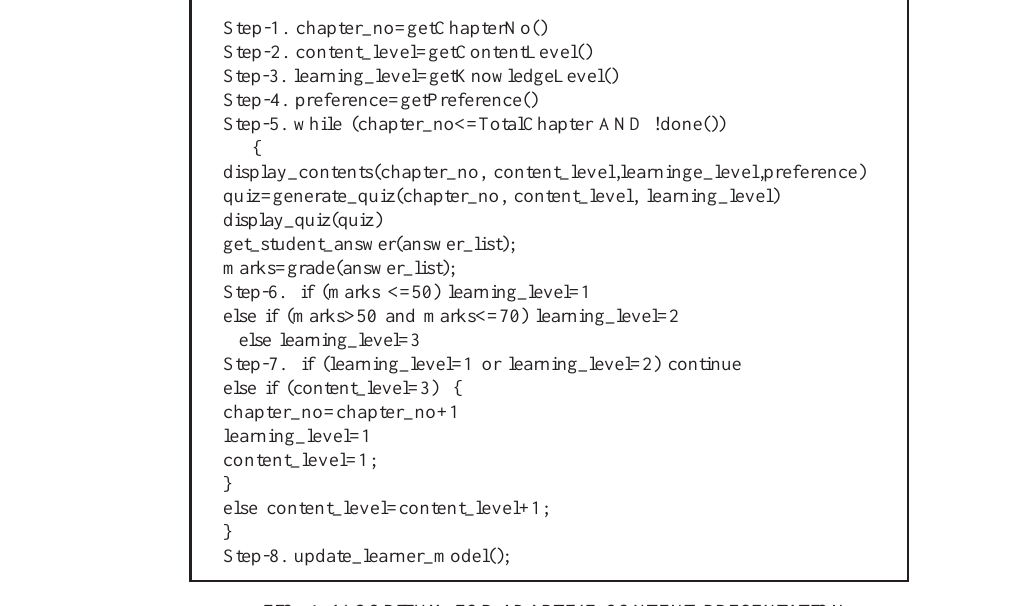
FIG. 4. ALGORITHM FOR ADAPTIVE CONTENT